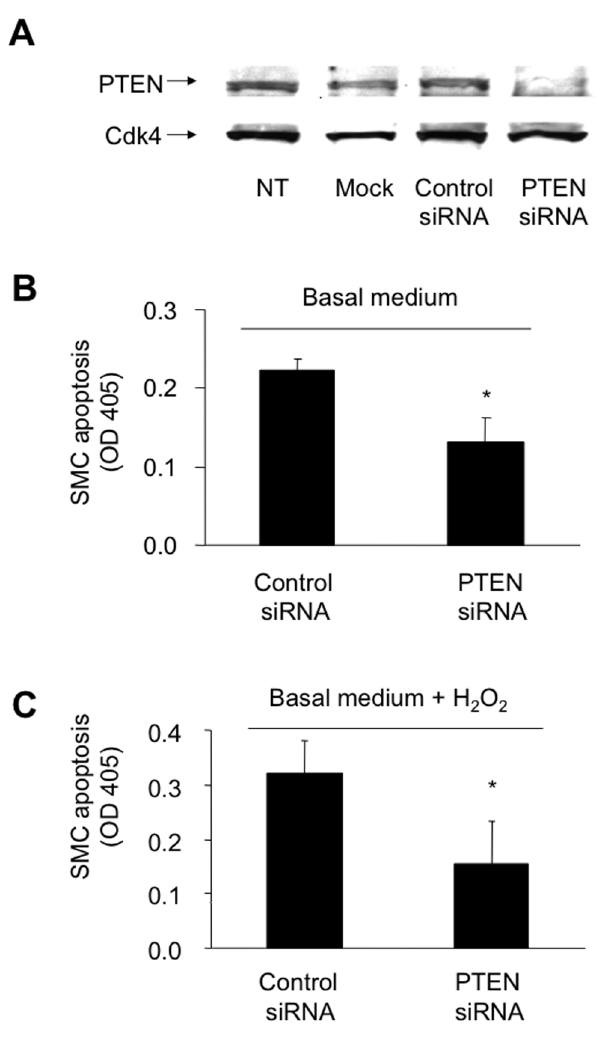
Figure 4. PTEN knock down attenuates SMC apoptosis under basal conditions or oxidative stress. A , PTEN expression following siRNA-mediated knock down. Protein expression was determined by western blotting using specific antibodies. Detection of Cdk4 served as a loading control. SMC were transfected as follows: non transfected (NT); mock transfected (without siRNA, but with lipid carrier); transfected with a non-targeting (scrambled) siRNA (Control siRNA); transfected with a targeting siRNA against PTEN (PTEN siRNA). SMC transfected with siRNA targeting PTEN or a scrambled control were incubated in basal medium in the absence ( B ) or presence of H 2 O 2 ( C ). SMC apoptosis is expressed as mean OD405 6 SD using a cell death detection ELISA (* P , 0.05;